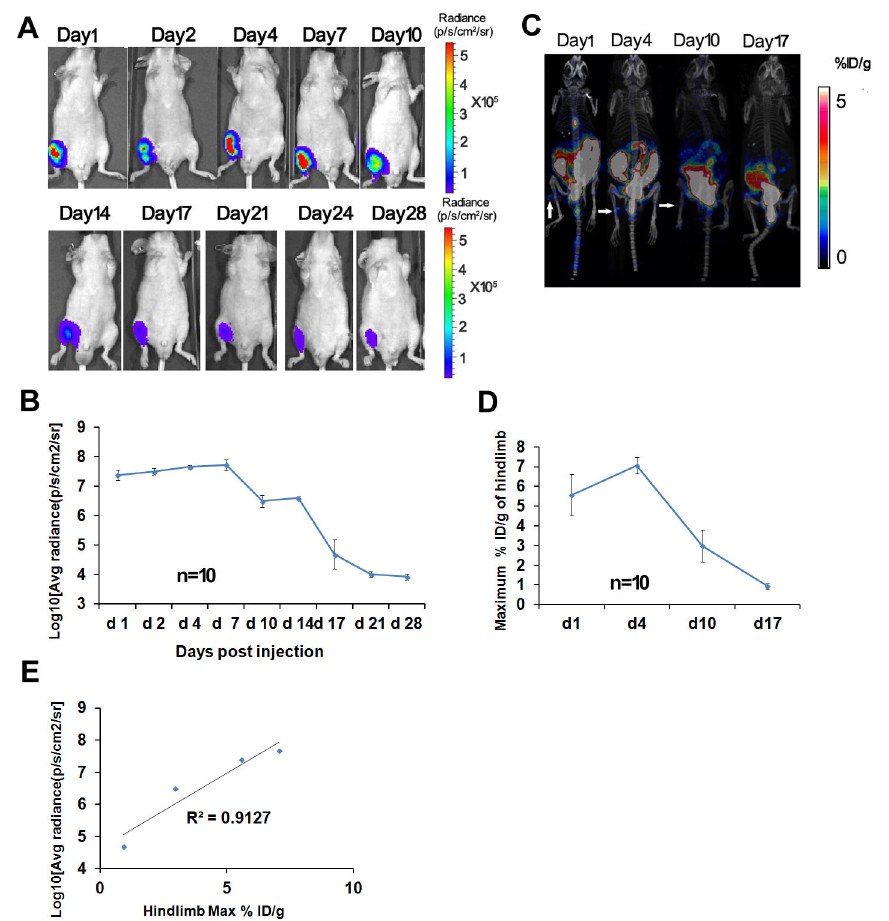
Figure 8. Survival of MSCs engrafted into the ischemic hindlimb. (A–B) Bioluminescence imaging of transplanted MSCs in mice with ischemic hindlimb (HLI). A representative mouse received 1 million MSCs by intramyocardial injection (n=10). To assess longitudinal cell survival, animals were imaged for 4 weeks. BLI signals were increased 5% in the first week, and then dropped to background levels after 4 weeks. p/s/cm 2 /sr = photons per second per cm 2 per steradian; p/s = photons per second. (C–D) Micro- PET imaging of the same mice. Following a bioluminescence scan, the mouse was imaged in microPET using FHBG on day 1, 4, 10 and 17. (E) Correlation of bioluminescence signal and FHBG accumulation in the MSCs injected hindlimb. Results demonstrated linear relationship, with R 2 values of 0.9127. p/s = photons per second; % ID/g = percentage of injection dose per gram. doi: